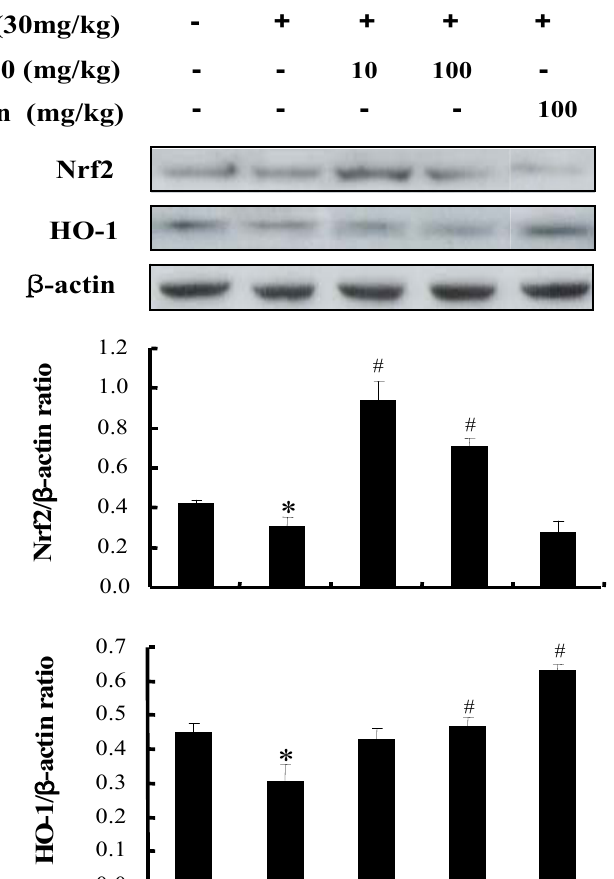
Figure 8. Effects of ginger extracts on Nrf2 and HO-1 protein expression in DEN-induced mice. Each value represents the mean ± S. D. for 4 mice. * p < 0.05, significantly different from the unstimulated control group. # p < 0.05, significant differences from the DEN-treated